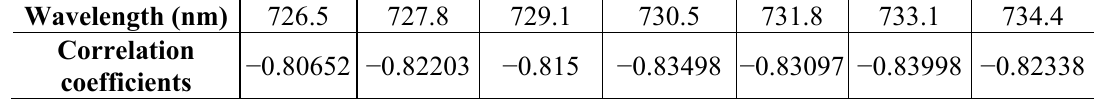
Table 1. The correlation between spectral reflectance and Chl- a concentration from 726.5–734.4 nm. Wavelength